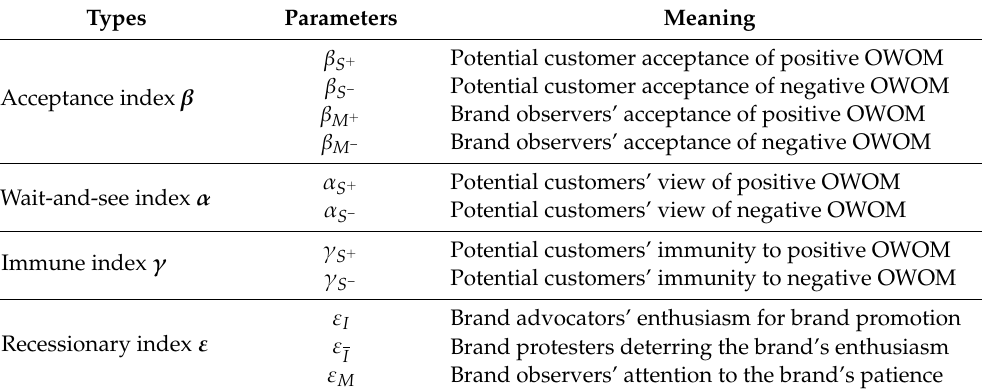
Table 2. Evolutionary relationship parameters of the brand OWOM communication